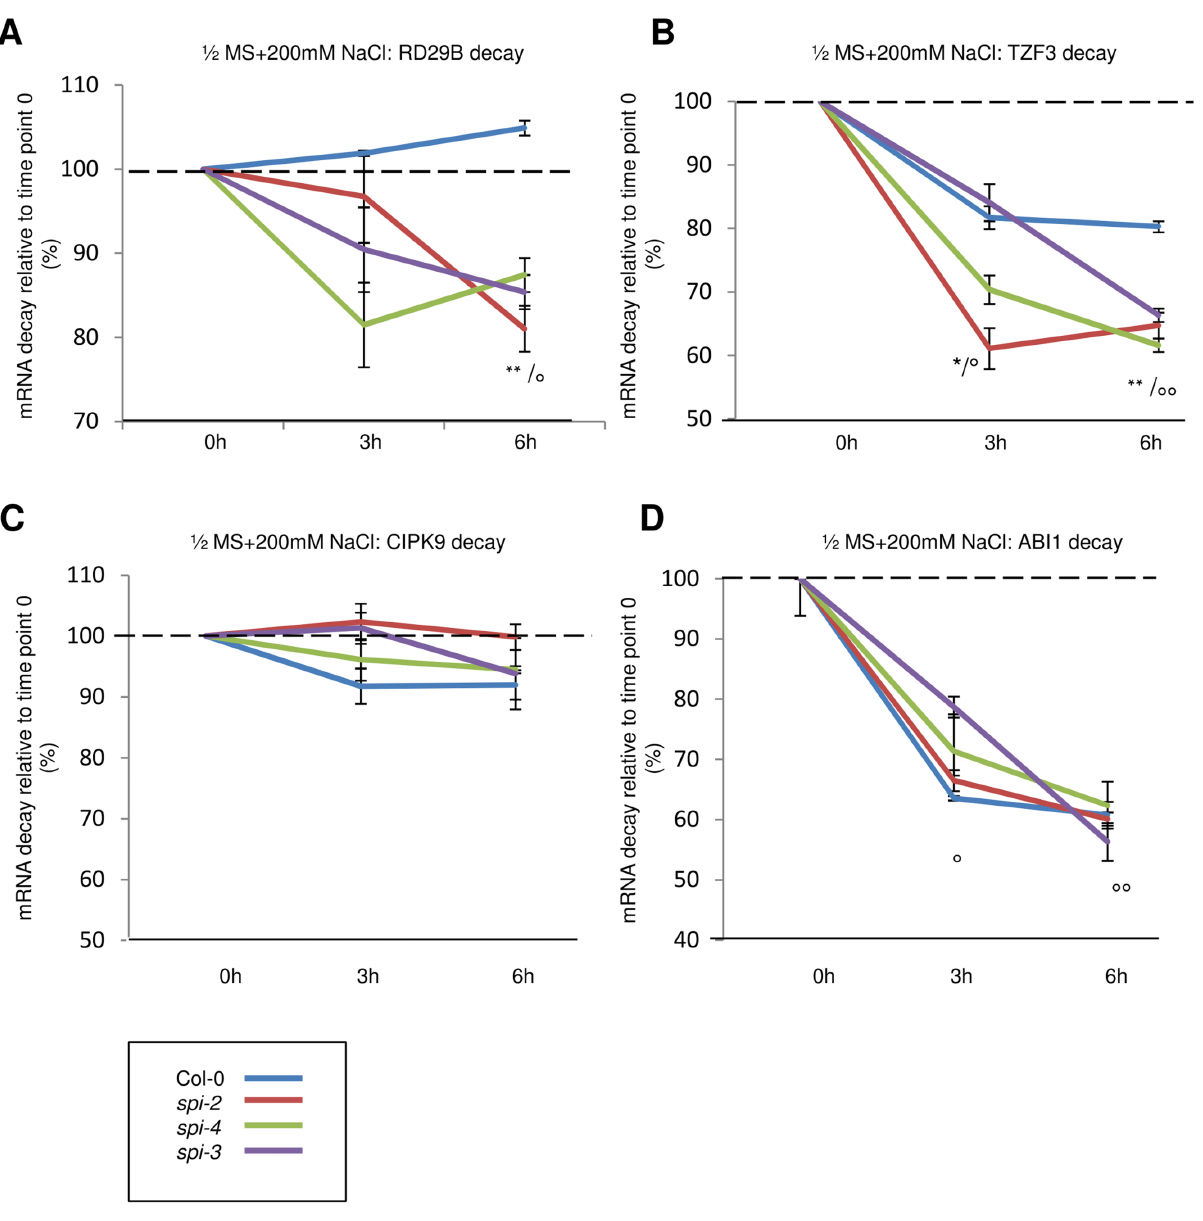
Fig 8. Role of SPI in the regulation of mRNA stability. mRNA stabilities (in %) were determined 3 h and 6 h after application of Actinomycin D (ActD) relative to time point 0 under salt stress conditions (200 mM NaCl in ½ MS liquid medium for 4 h). mRNA decay was determined for RD29B (A), TZF3 (B), CIPK9 (C), and ABI1 (D). Data denote the average from three independent biological and two technical replicates. Error bars represent the standard error of the mean. Two-tailed student ’ s t tests were performed to compare 18S rRNA normalized expression levels either of spi alleles with that of wild-type ( * p < 0.05; ** p < 0.01 of all spi alleles), or of ActD-treated samples with that of untreated samples (time point 0) (° p < 0.05; °° p < 0.01 of all treated